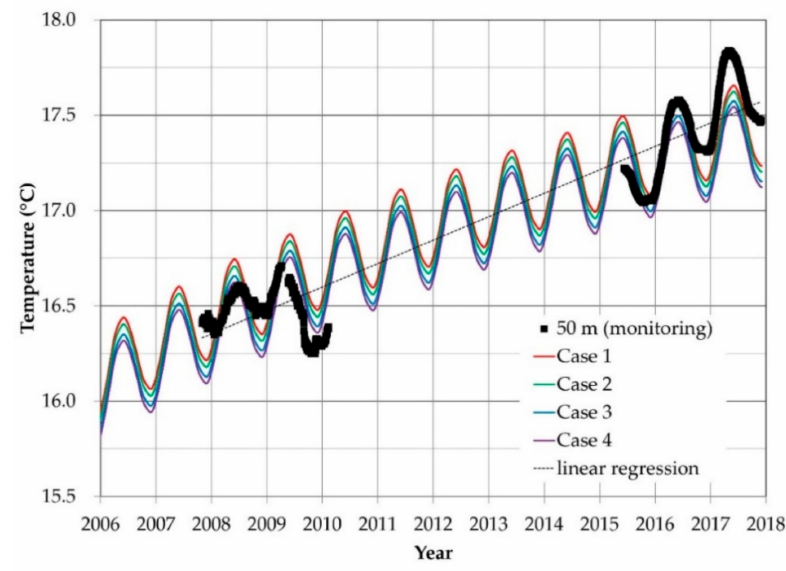
Figure 8. Comparisons of simulated and measured temperatures at the depth of 50 m in the monitoring well for 12 years of operation.